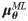
Model results for Session 1.A. Model simulation results with the estimated parameters mi’s (Session 1). The model captures the asymmetry that is seen in the data (see Fig 3). The model was simulated in the same conditions (Session 1) as the actual experiment for each participant for 500 repetitions. The mean and the standard error of the mean of each participant group is shown. B. Model estimate with the estimated group means μθML.